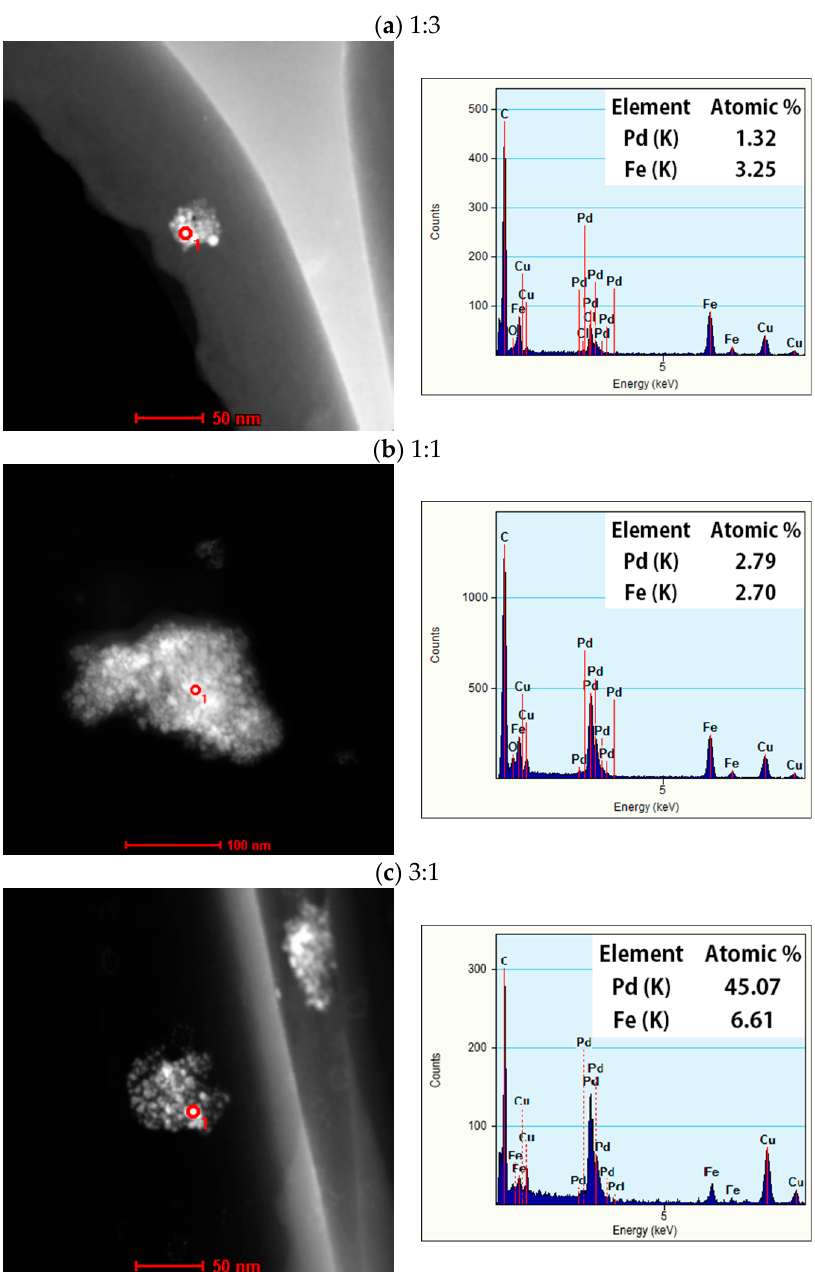
Figure 7. HAADF-STEM image and EDX analysis of upper 1:3 ( a ); 1:1 ( b ); and 3:1 ( c ) Pd-Fe alloy nanoparticles.